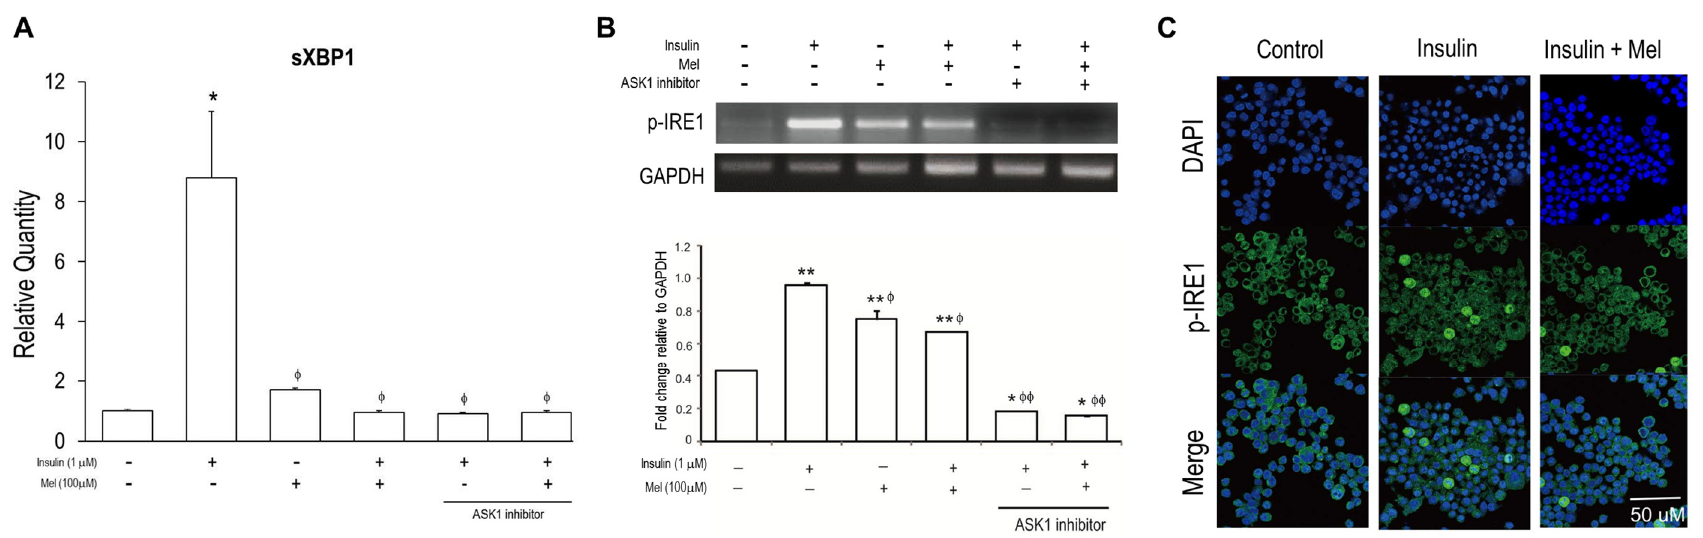
Figure 4. Melatonin alleviates IR ‐ induced ER stress signaling (sXBP1 and p ‐ IRE1 ) in the SH ‐ SY5Y neuronal cells. ( A ) The mRNA levels of sXBP1 were measured by quantitative real time PCR; ( B ) The mRNA levels of activation of IRE1 ( p ‐ IRE1 ) were measured by reverse transcription PCR. Data are expressed as mean ± standard error and each experiment included three repeats per conditions. * p < 0.05, ** p < 0.01 compared with non ‐ stimulated control; φ p < 0.05, φφ p < 0.001 compared with insulin stimulated cells; ( C ) p ‐ IRE1 was visualized by immunofluorescence staining using confocal microscopy analysis. p ‐ IRE1 is represented by green staining, nuclear DNA is indicated by 4 ′ ,6 ‐ diamidino ‐ 2 ‐ phenylindole (DAPI) staining (blue color), and the combined images are presented. Mel: melatonin pretreatment for 24 h before insulin stimulation; ASK1 inhibitor: NQDI ‐ 1 600 nM treatment for 2 h before sampling.